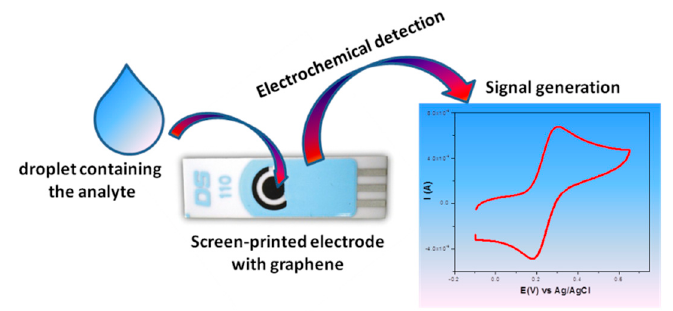
Scheme 1. Representation of a screen-printed electrode modified with graphene and its application for the detection of 8-hydroxy-2 ′ -deoxyguanosine.